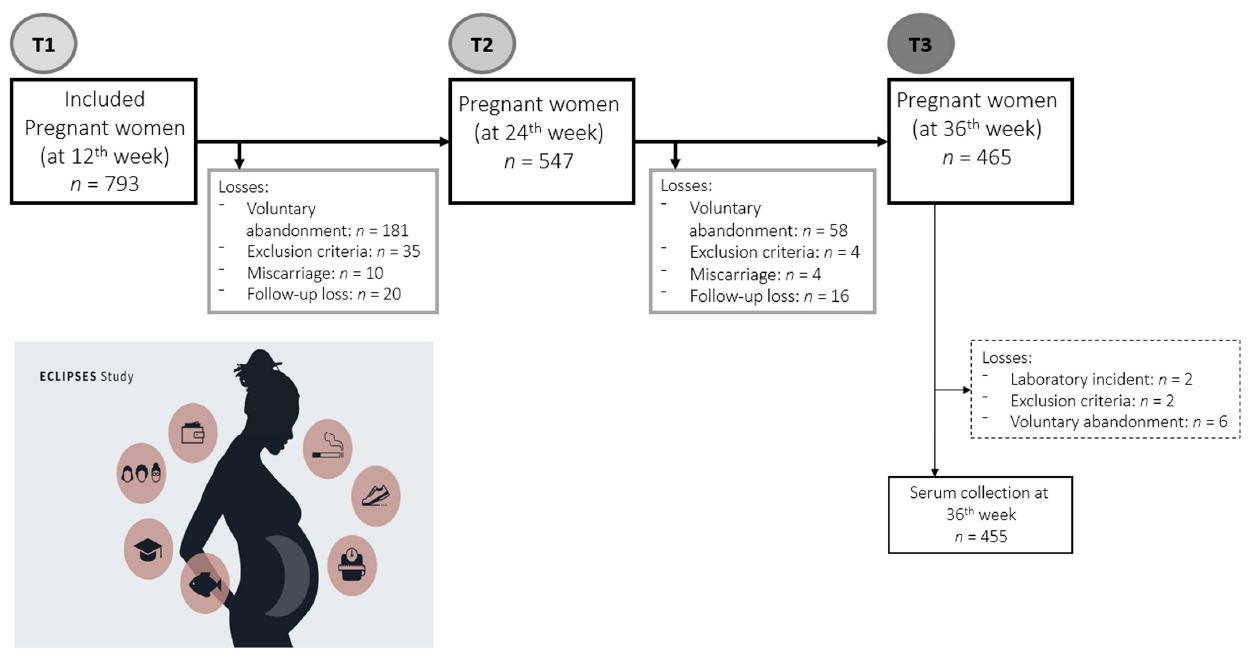
Figure 1. The flow of participants and serum collection during